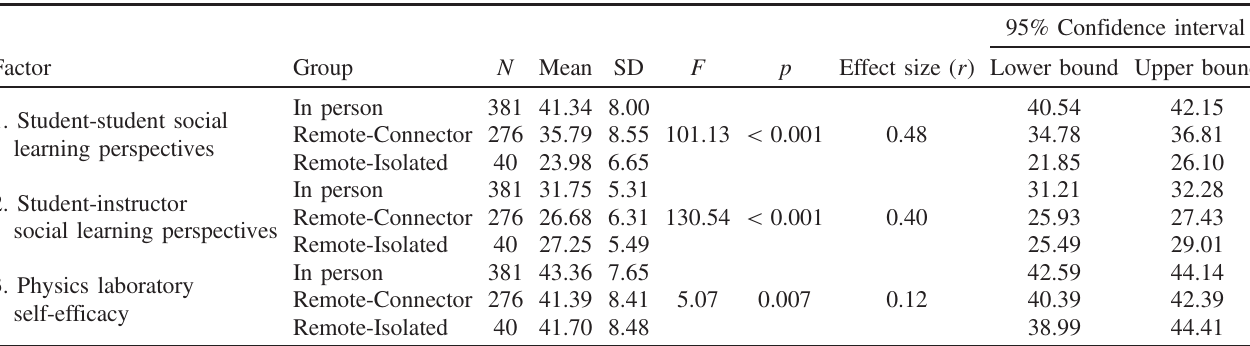
95% Confidence interval